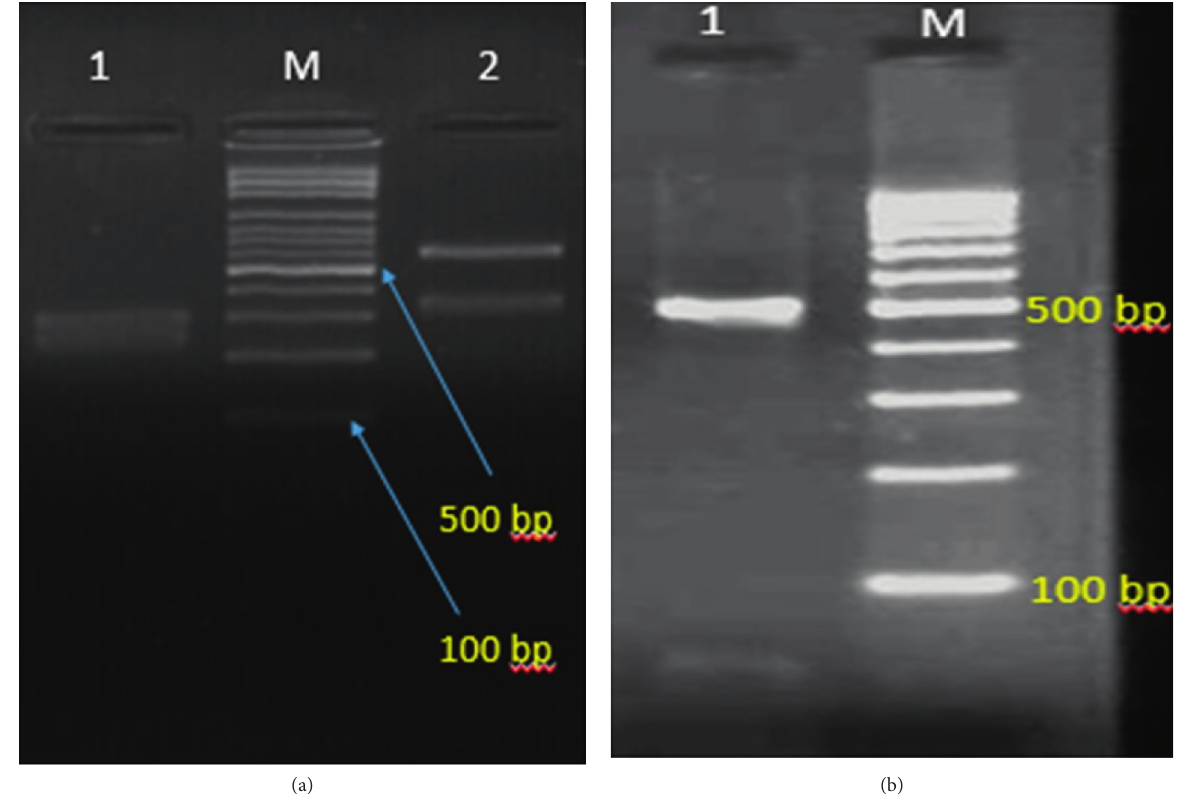
Figure 2: Digested ITS-PCR products with Msp I. (a) Lane 1: C. krusei; lane M: 100bp DNA size marker; and lane 2: C. glabrata . (b) Lane 1: C. parapsilosis and lane M: 100bp DNA size